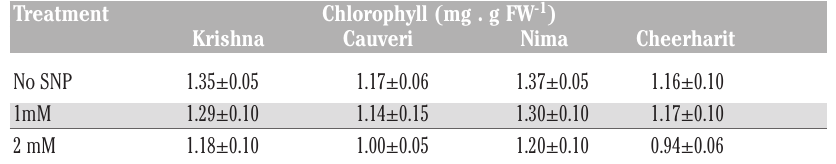
Table 2. Effect of sodium nitroprusside (SNP) on leaf protein content in Cymbopogon flex- uosus varieties, Krishna, Cauveri, Nima and Cheerharit. A 15 d lemongrass tiller